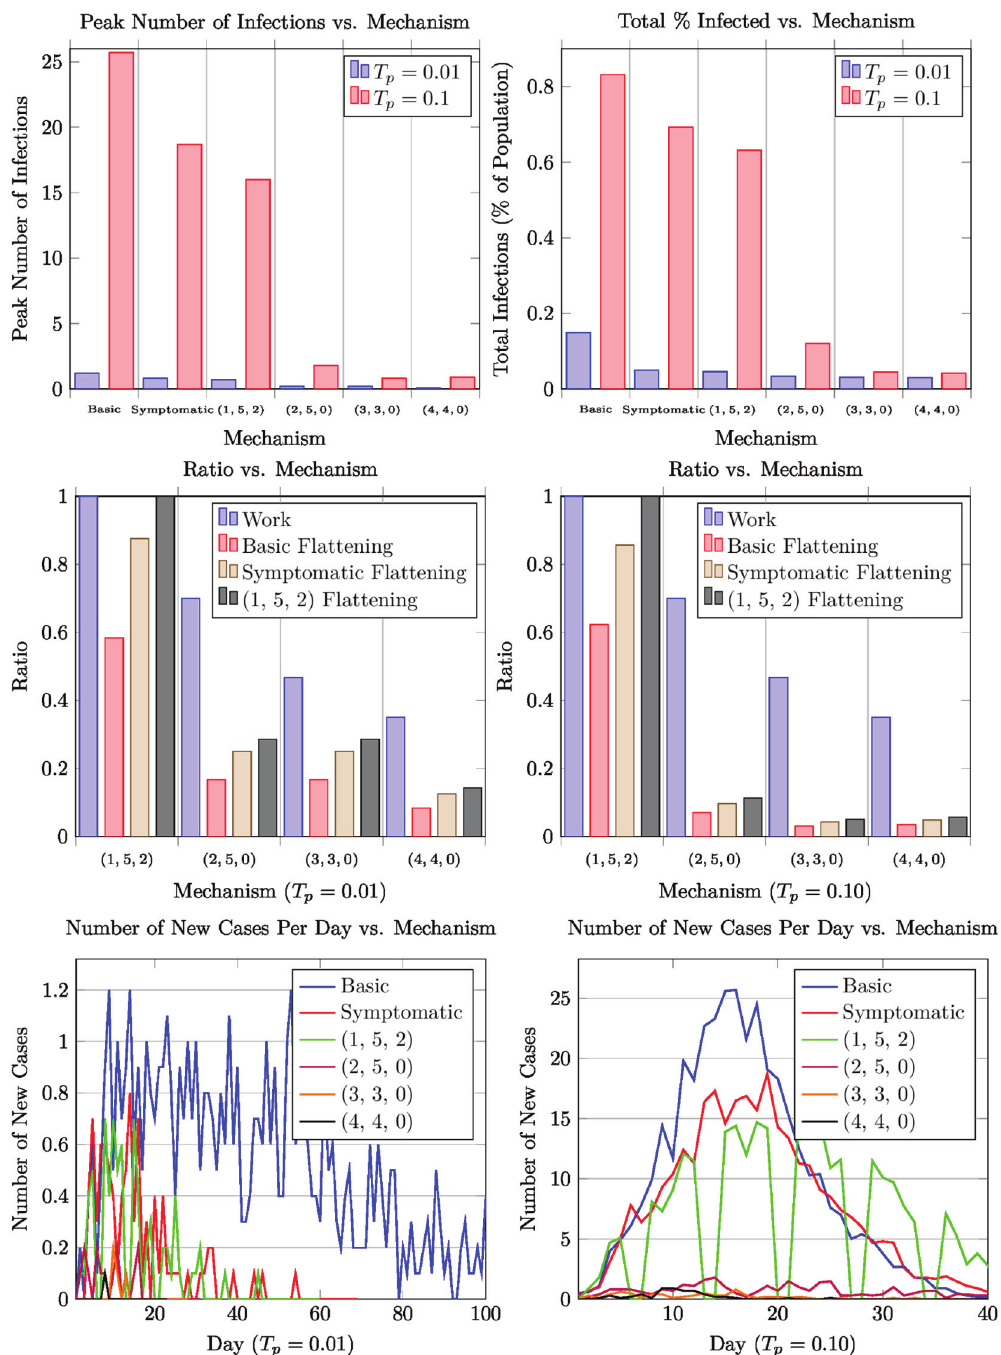
Fig 4. Plots displaying the performance of different mechanisms for modified Haslemere dataset.